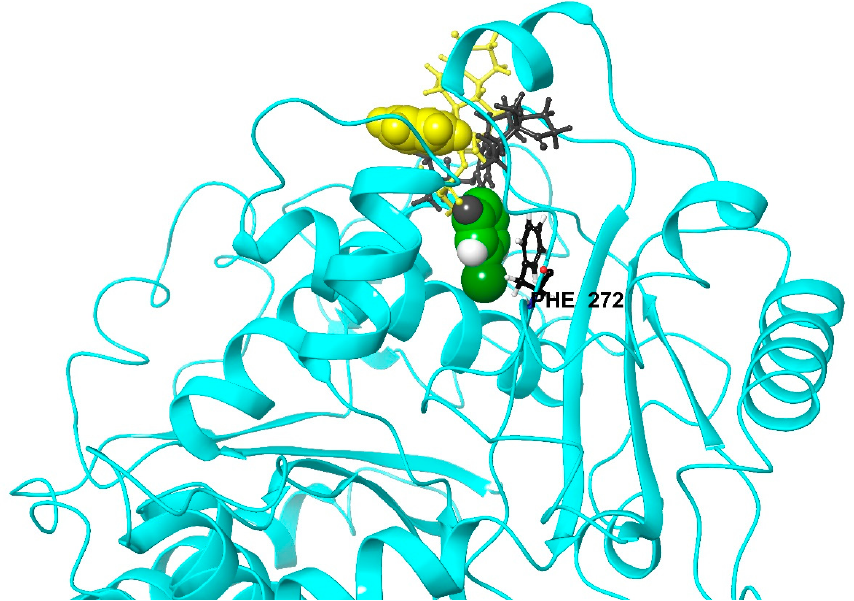
Figure 9. Representative binding positions of ligands 13AES2 (yellow) and 13AES3 (green). The blue ribbon represents the protein backbone of β -tubulin, and the atoms of the two phenyl rings at position 2 are represented by Van der Waals balls. The Phe272 residue of special interest is also shown in a stacking geometry for ligand 13AES3.